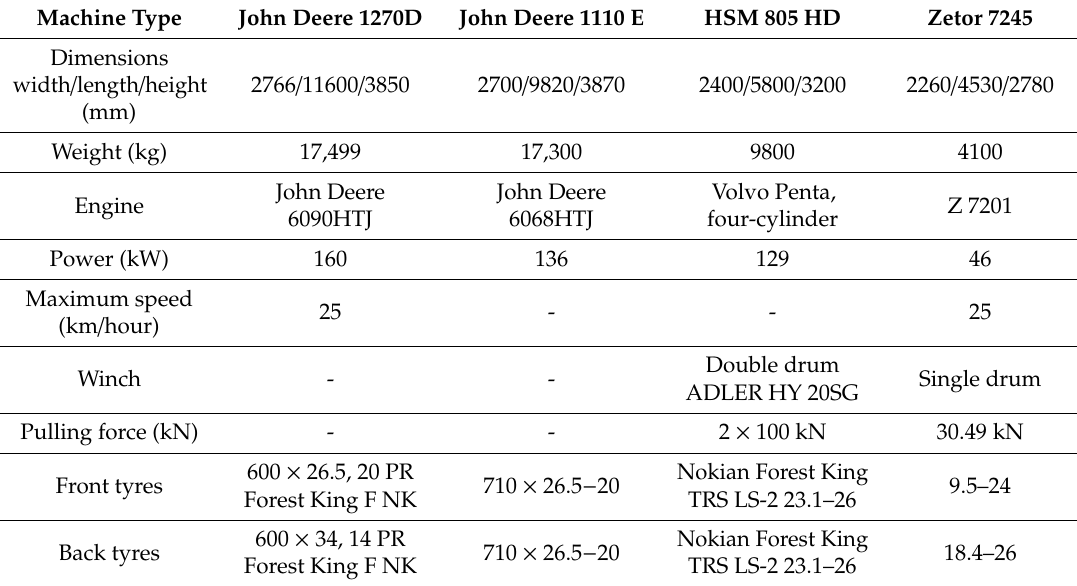
Table 2. Basic information on applied